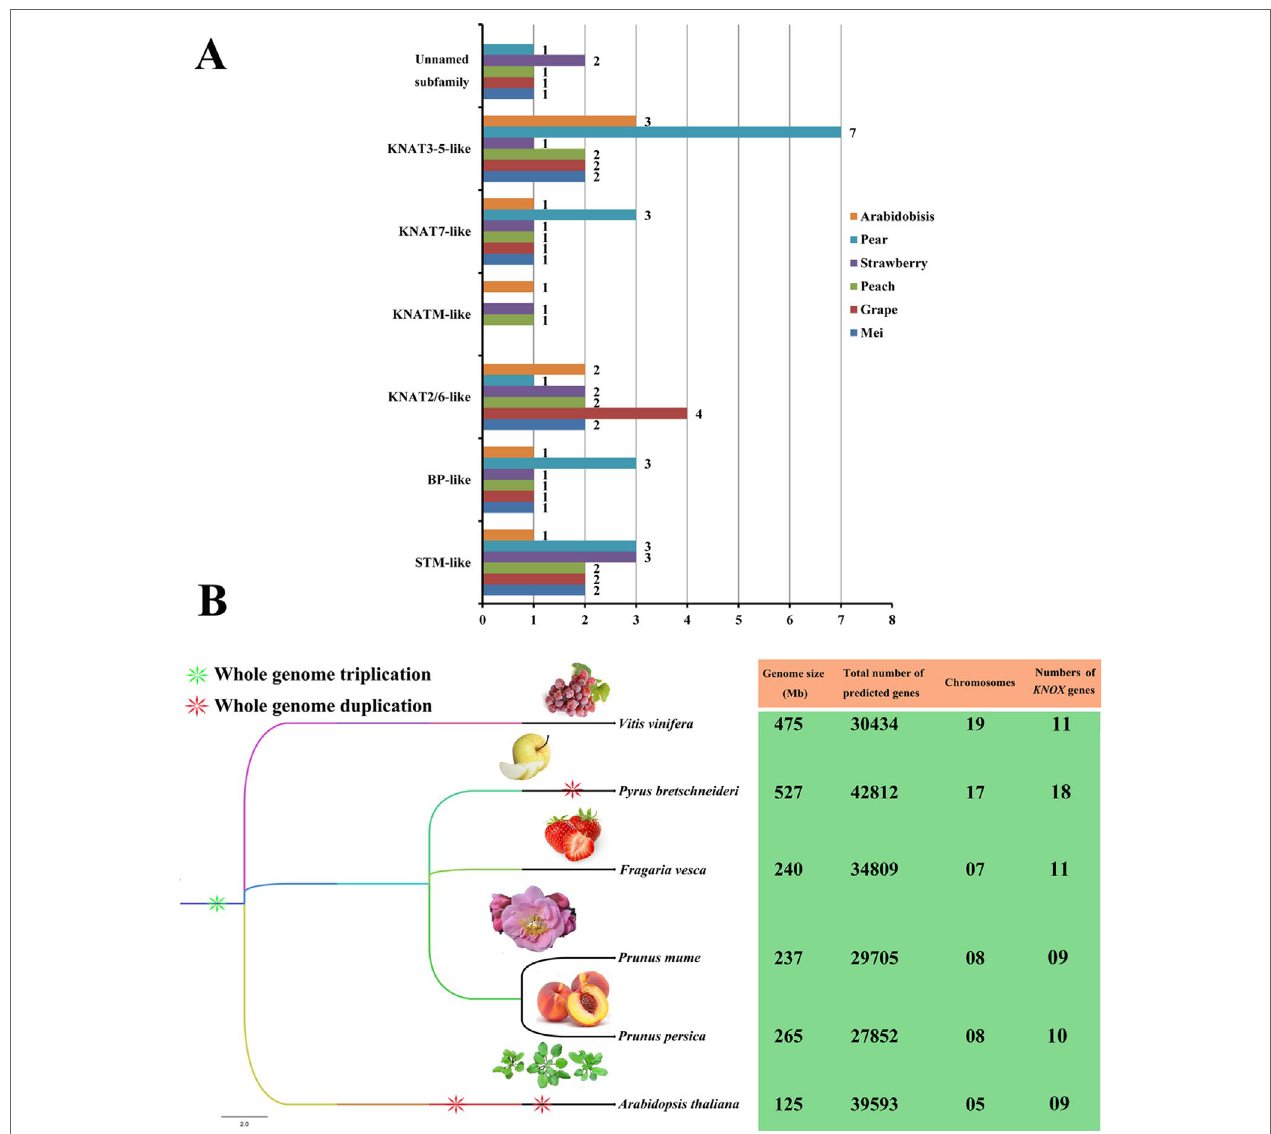
FIGURE 3 | Subclade distributions and numbers of KNOX genes in different rosids. (A) Distributions of members of each subclade of the KNOX family from mei, grape, peach, strawberry, pear, and Arabidopsis . The number of KNOX proteins corresponding to each subclade is shown. (B) The species phylogenetic tree was obtained from Common Taxonomy Tree (https://www.ncbi.nlm.nih.gov/Taxonomy/CommonTree/wwwcmt.cgi) and was viewed in FigTree 1.4.3 (http://tree.bio.